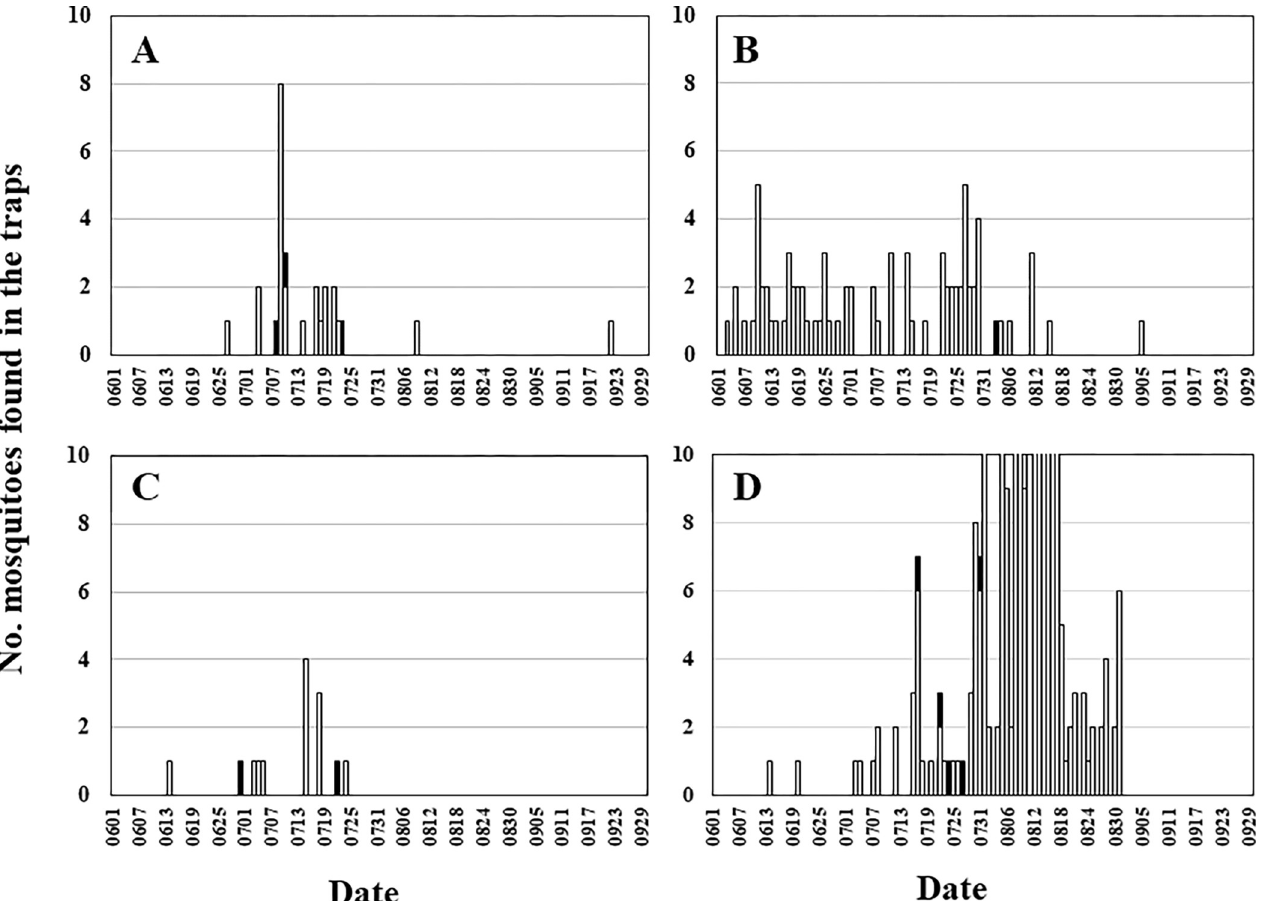
Fig 4. The days of Cx . tritaeniorhynchus capture in net-traps (NTs) and a Johnson-Taylor suction trap (JT-ST) installed at four localities on the Kyushu District. A : Saga City in 2009, B : Minami-Satsuma City in 2009, C : Goto City in 2010, D : Iki City in 2010. Open and solid bars indicate Ct -J and Ct -C subtypes of the Cx . tritaeniorhynchus , respectively, which were determined by the partial COI sequences (658 bp).